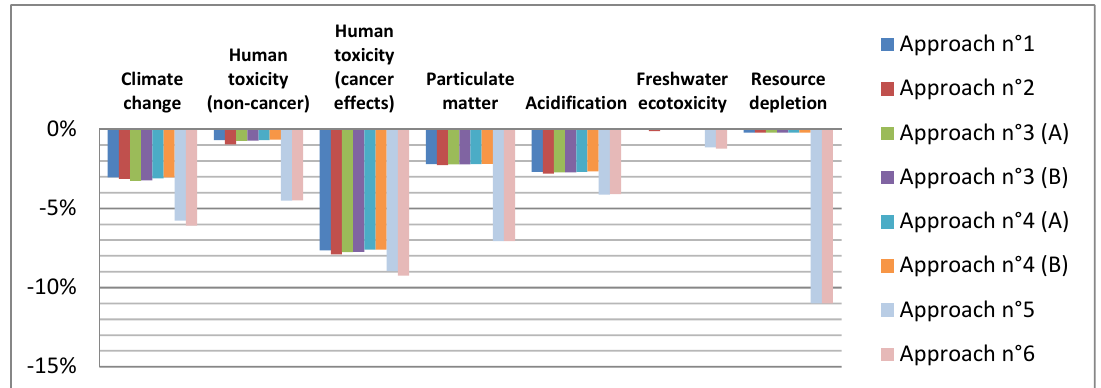
Figure 4. Potential contribution of waste management to the environmental profile of electricity production with mono-Si modules (for numerical values see Appendix A, Table A1).